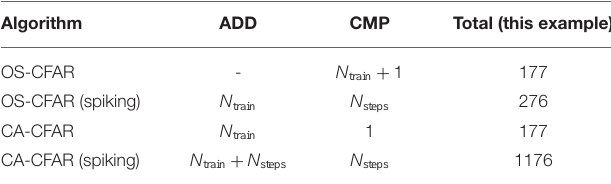
TABLE 1 | Comparison of computational cost of spiking and conventional CFAR